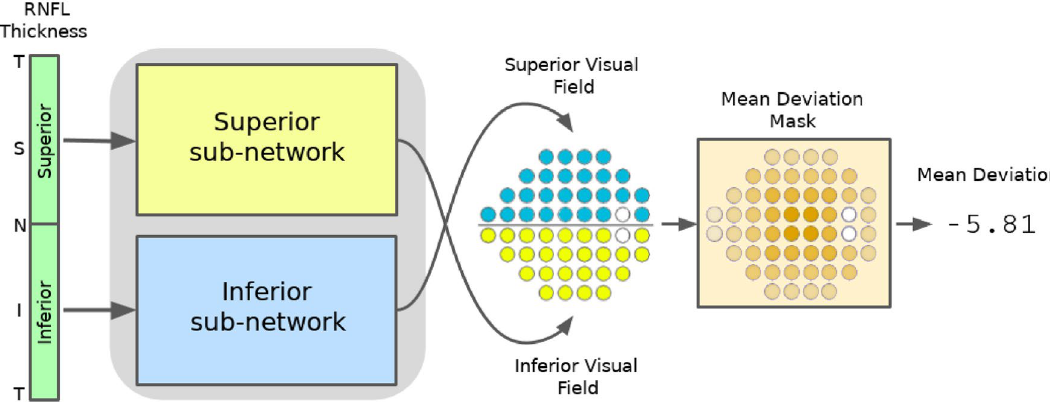
Figure 5. Overview of the RetiNerveNet structure: A 768-dimensional RNFL thickness vector obtained from the SDOCT test, arranged in the Temporal-Superior-Nasal-Inferior-Temporal (TSNIT) order, is split into two halves having size 384. As the retinal ganglion fibers in the eye do not cross into the opposite hemiretina, we use separate sub-networks to estimate the superior and inferior visual fields. The superior (inferior) half of the RNFL thickness values proceeds through the superior (inferior) sub-network of the RetiNerveNet to yield an estimate of the inferior (superior) half of the visual field. For the multi-task version of RetiNerveNet, a weight mask is applied to the estimated visual field to obtain a scalar estimate of Mean